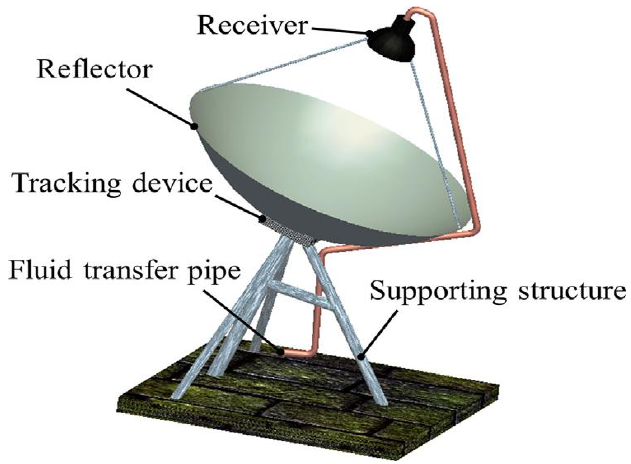
Figure 9. Parabolic dish reflector (PDR)